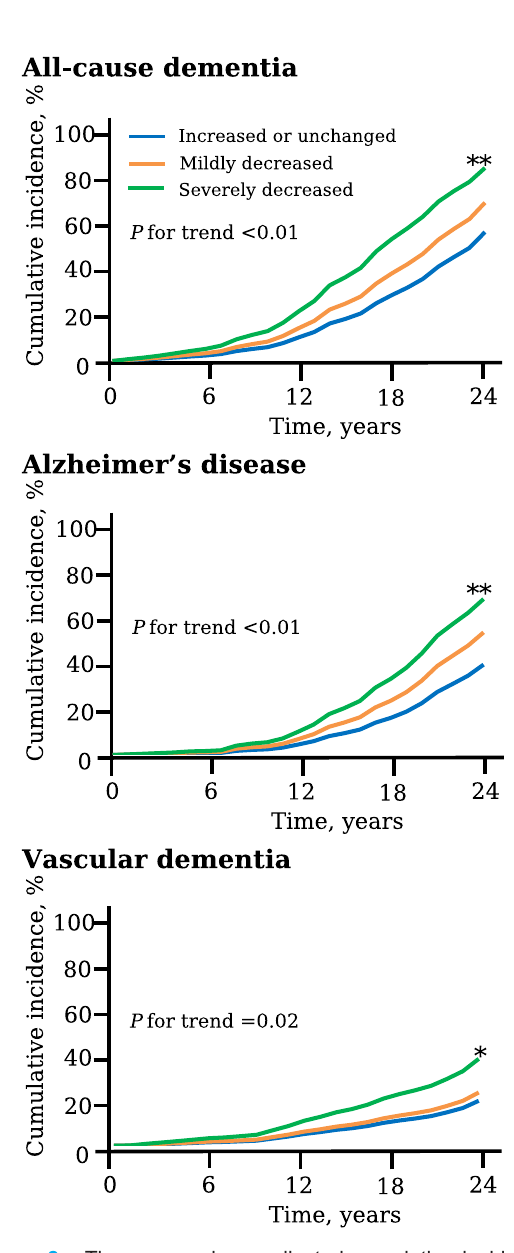
Figure 2. The age- and sex-adjusted cumulative incidence for total dementia and its subtypes according to %change of handgrip strength, the Hisayama Study, 1988 – 2012. The %change of handgrip strength was divided into three groups: increased or unchanged, ; + 0%; mildly decreased, % 14 to % 1%; severely decreased, :%